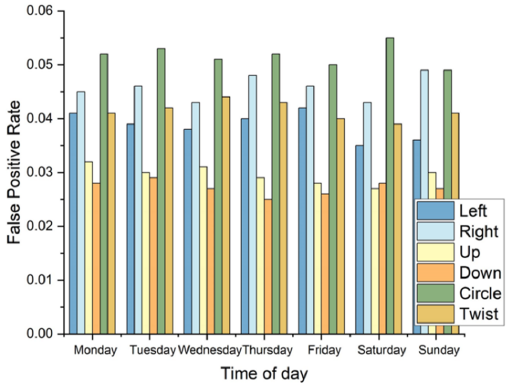
Figure 19. Robustness verification.